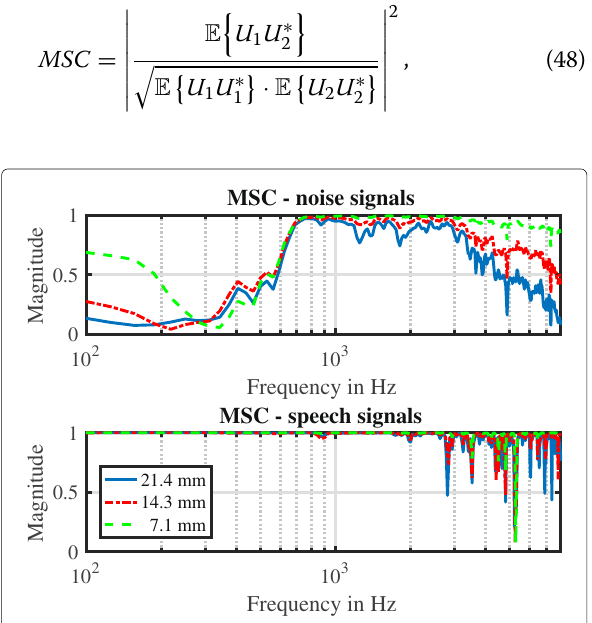
Fig. 2 Magnitude squared coherence for the noise signals N 1 and N 2 (top) as well as the speech signals S 1 and S 2 (bottom) with different microphone